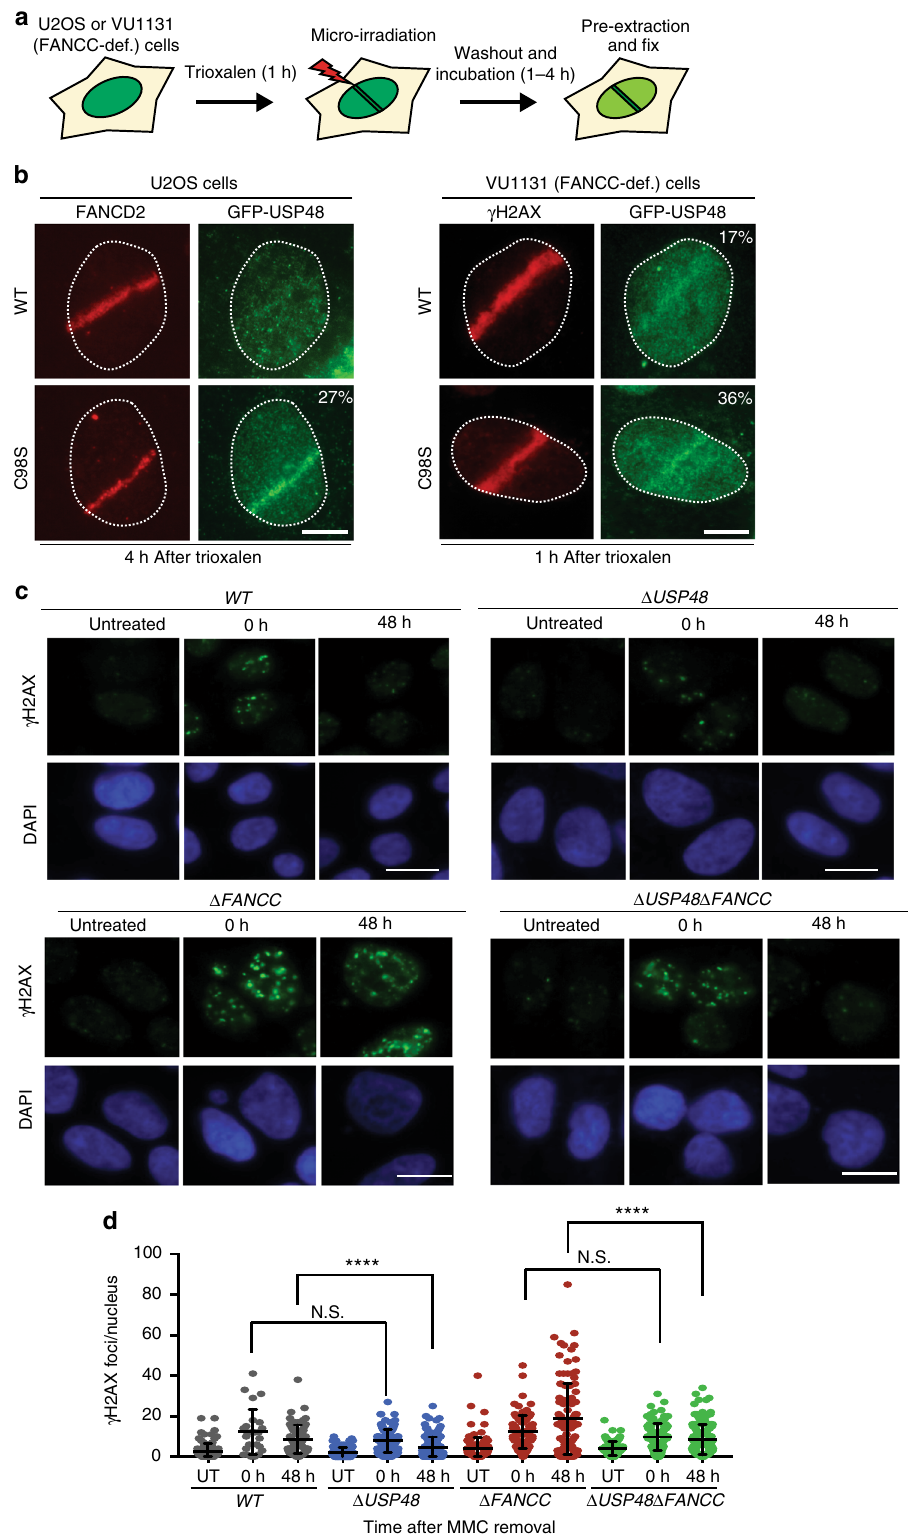
Fig. 4 USP48 is recruited to ICLs and attenuates clearance of γ H2AX foci. a Work fl ow for the recruitment of proteins to ICLs in U2OS and VU1131 cells. b Localization of FANCD2 and GFP-USP48 (WT and C98S mutant) to sites of laser micro-irradiation after Trioxalen treatment in U2OS and VU1131 cells. Scale bar = 10 μ m. c Representative immuno fl uorescence images after staining for γ H2AX on WT, Δ USP48, Δ FANCC , and Δ USP48 Δ FANCC cells after treatment with MMC (30 nM) for 18 h and then recovery for the indicated time-points. Scale bar = 10 μ m. d Quanti fi cation of γ H2AX foci of the indicated cell lines. UT untreated cells. Quanti fi cation was performed using the Cell Pro fi ler software. Error bars show mean with S.D. (standard deviation). Statistical signi fi cance was determined by Wilcoxon test with p < 0.05 as threshold. N.S. not signi fi cant; **** = p <